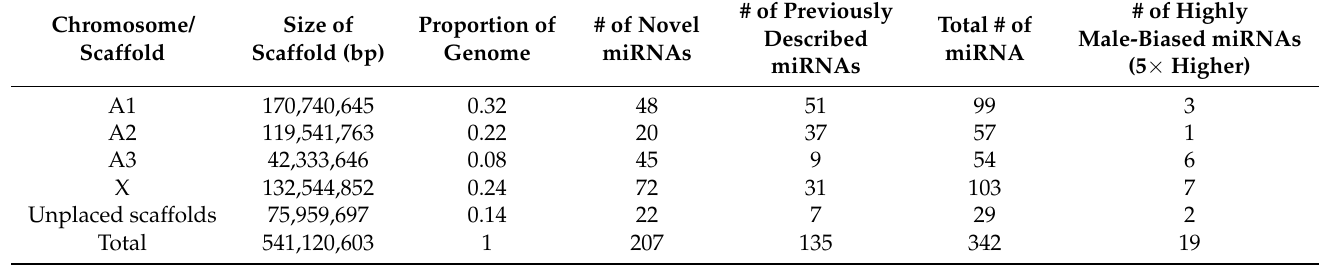
Table 1. miRNA coding loci distribution summary.